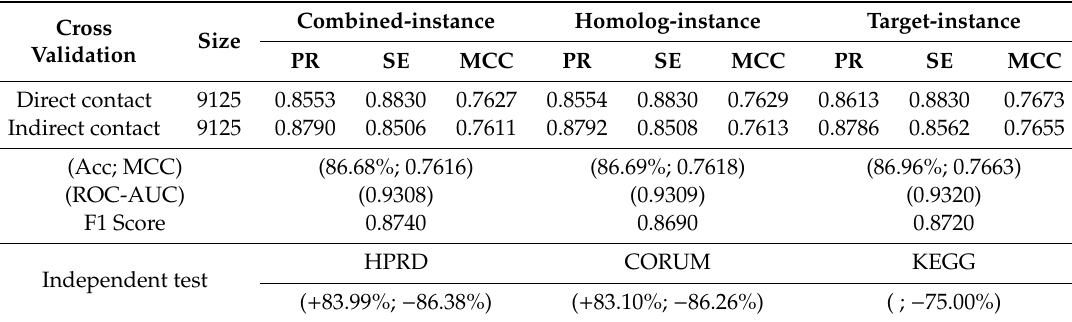
Figure 2. Performance of 5-fold cross validation ( A ) and independent test ( B ). Table 1. Performance of cross validation and independent